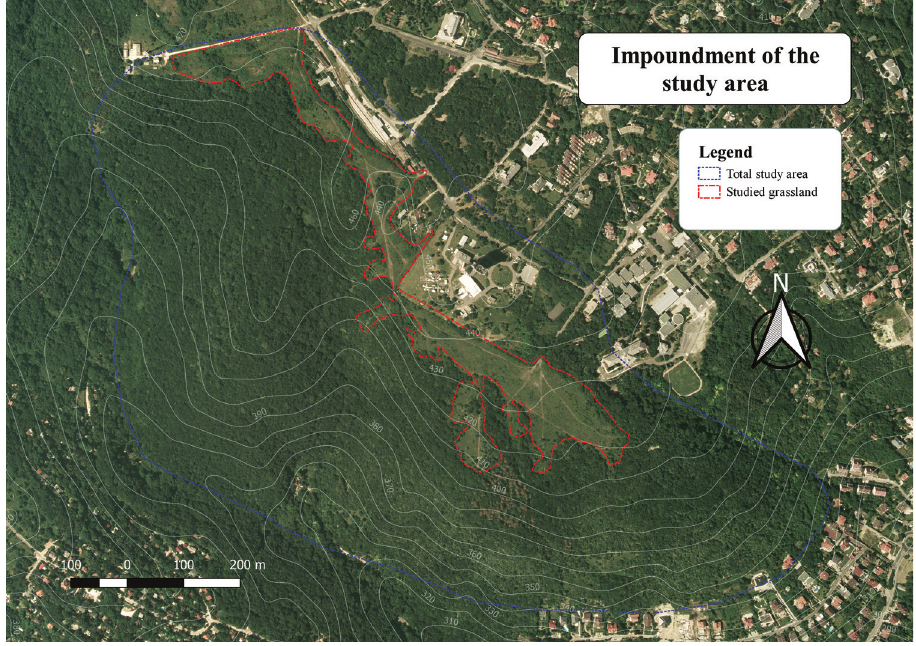
Figure 2. Impoundment of the study area (based on Google Earth satellite